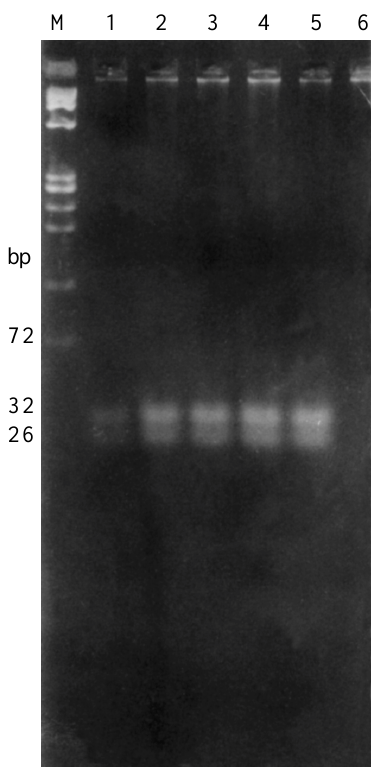
Figure 2 - Agarose gel electrophoresis of amplified DNA from Gir bulls following restriction digestion with Taq I. All animals were identified as normal homozygotes, i.e, BLAD-free